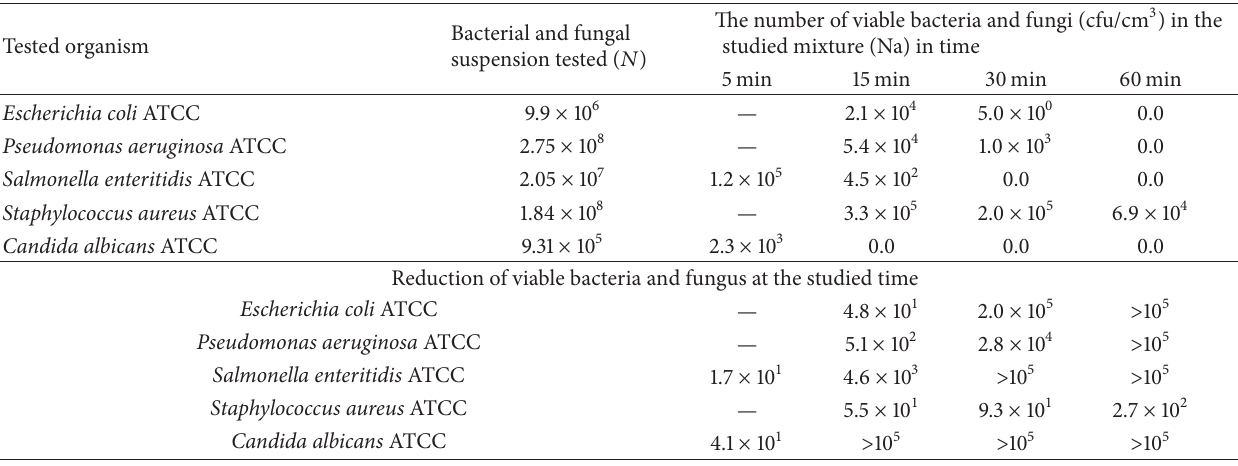
Table 8: Results of the evaluation using the dilution-neutralisation method for suspension number 8. Tested